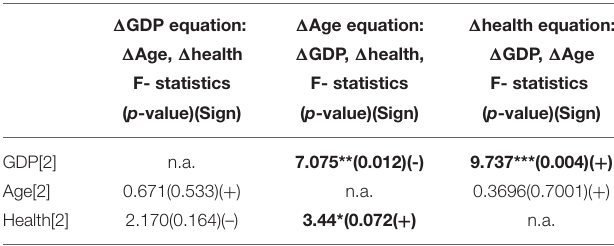
TABLE 4 | ARDL Granger-causality